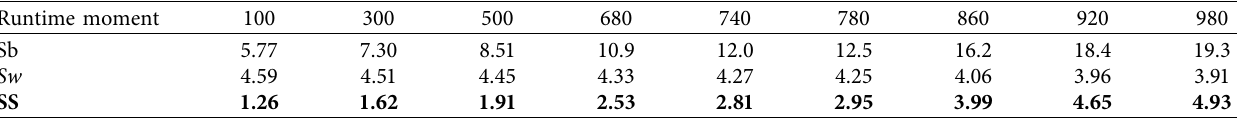
Figure 4: Two-dimensional feature clustering distribution based on the reference model at different runtime moments: (a) 100, (b) 300, (c) 500, (d) 680, (e) 740, (f) 780, (g) 860, (h) 920, and (i) Table 2: The feature clustering indicator for the monitor dataset at different runtime moments.